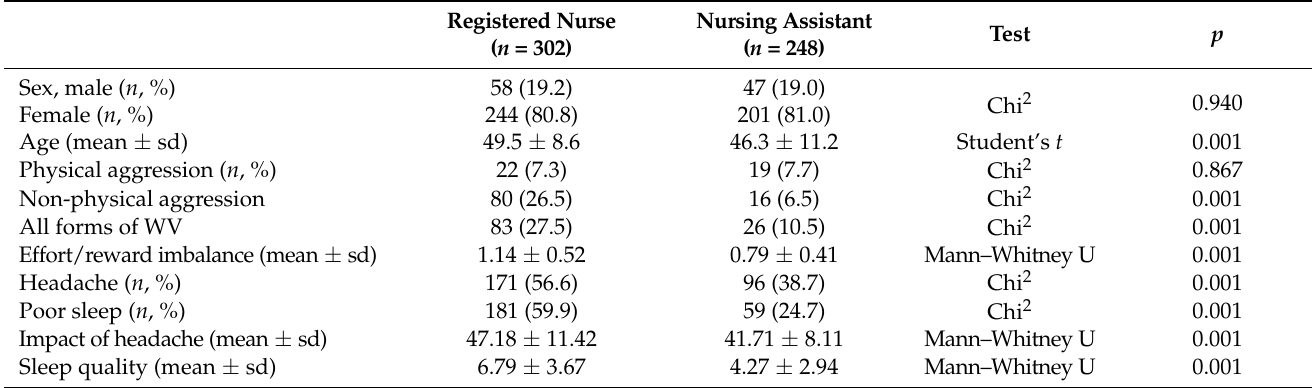
Table 1. Characteristics of the population and comparison between registered nurses and nursing assistants.